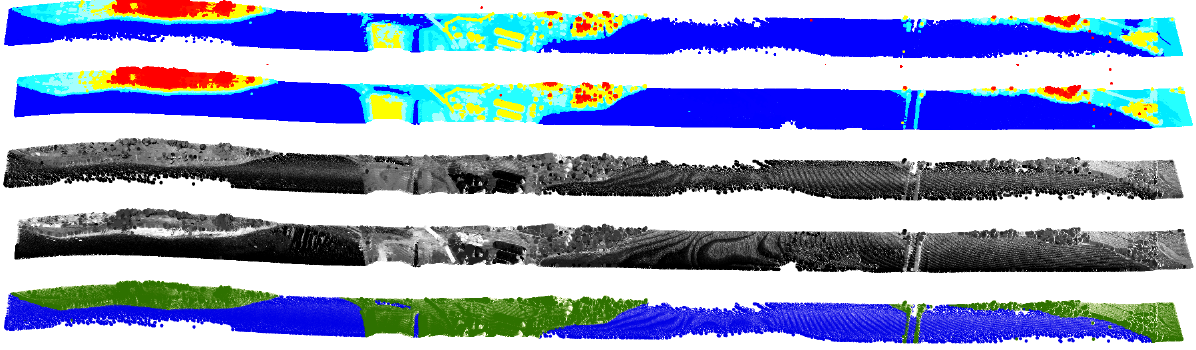
Figure 3. First dataset - Bowmanville (from top to bottom): LiDAR elevation displayed of channel 2 and 3, LiDAR intensity of channel 2 and 3 and classification result (green = land, blue = water).